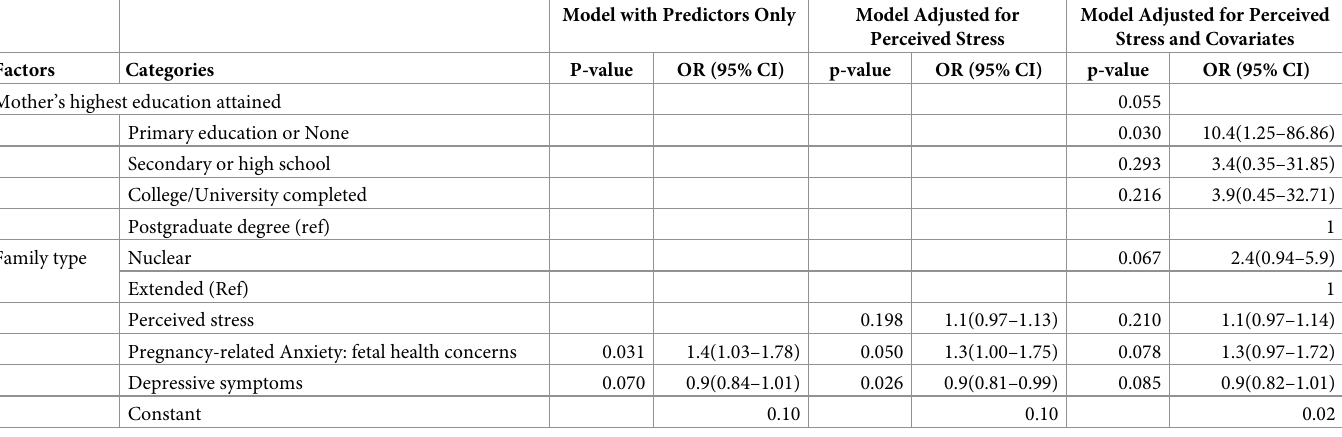
Table 6. Predictive model for preterm birth given changes in dimensions of pregnancy-related anxiety and depressive symptoms during pregnancy adjusted for per- ceived stress and covariates. Model with Predictors